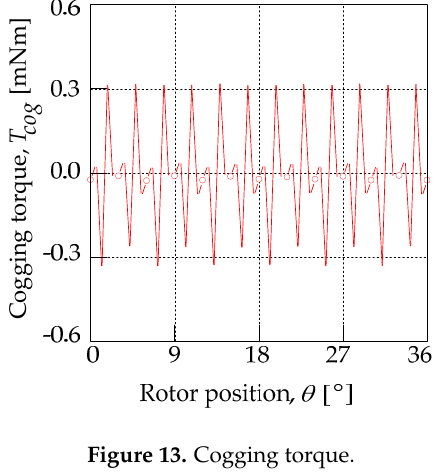
Figure 13. Cogging torque.